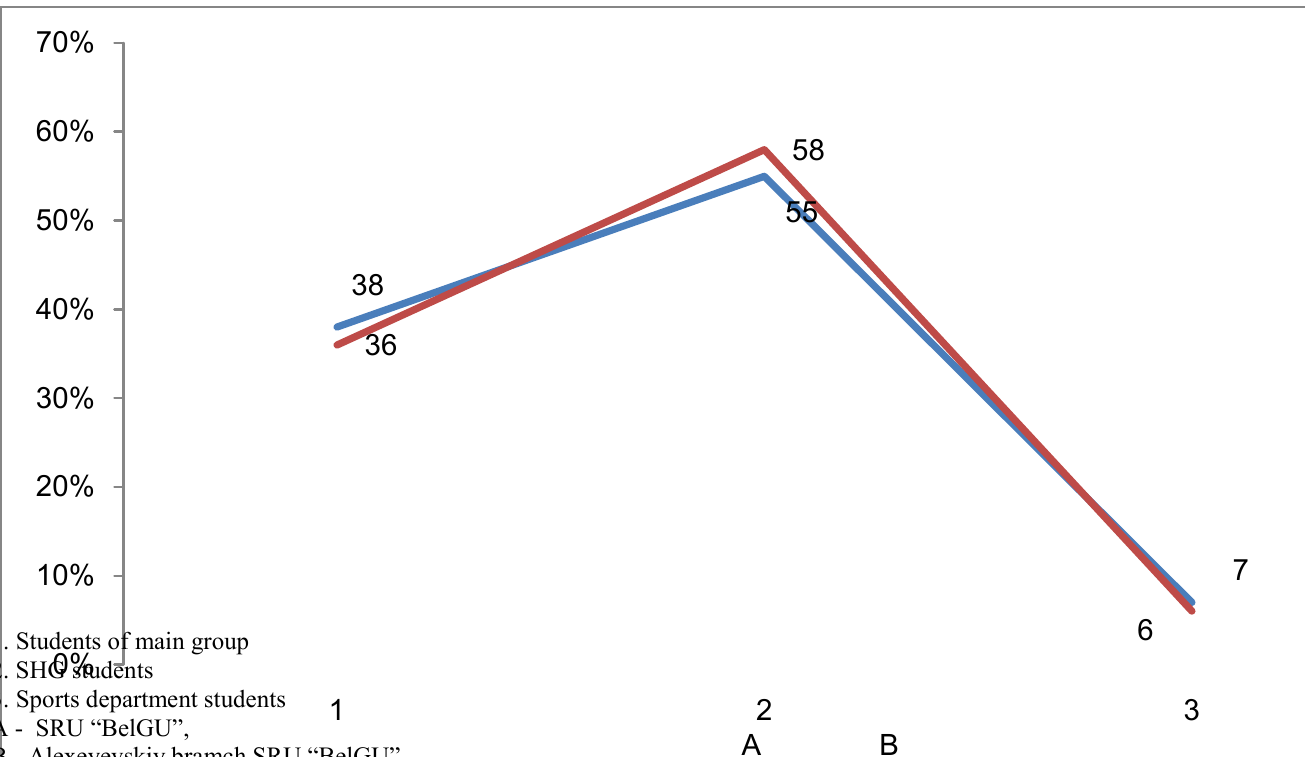
Fig.7. Morbidity level of different students’ group, studying and living in urban environment (BSNRU), and in the country (AB